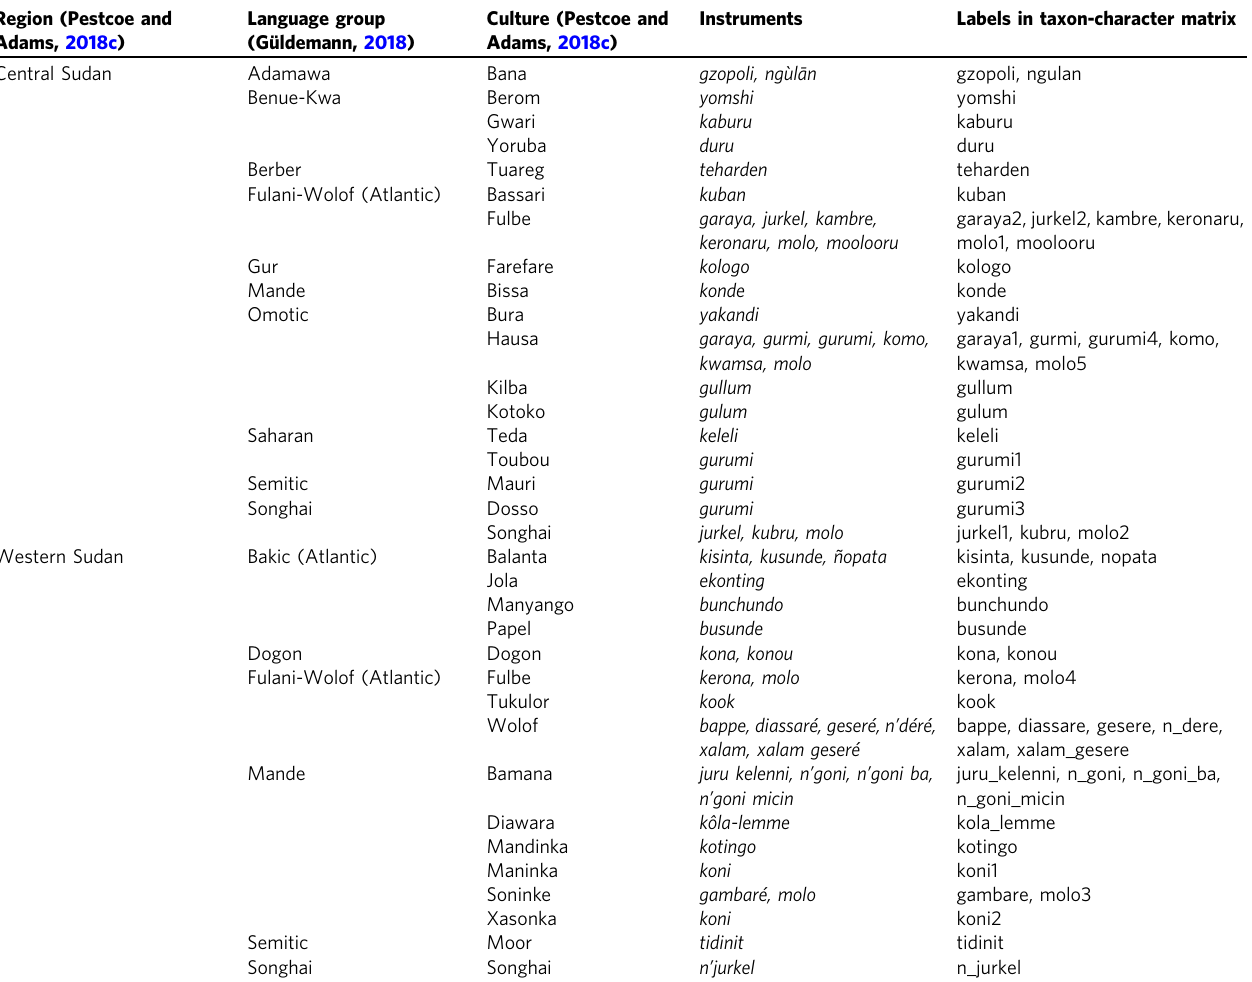
Table 1 List of West African instruments incorporated into the cluster analyses. Region (Pestcoe and Adams,